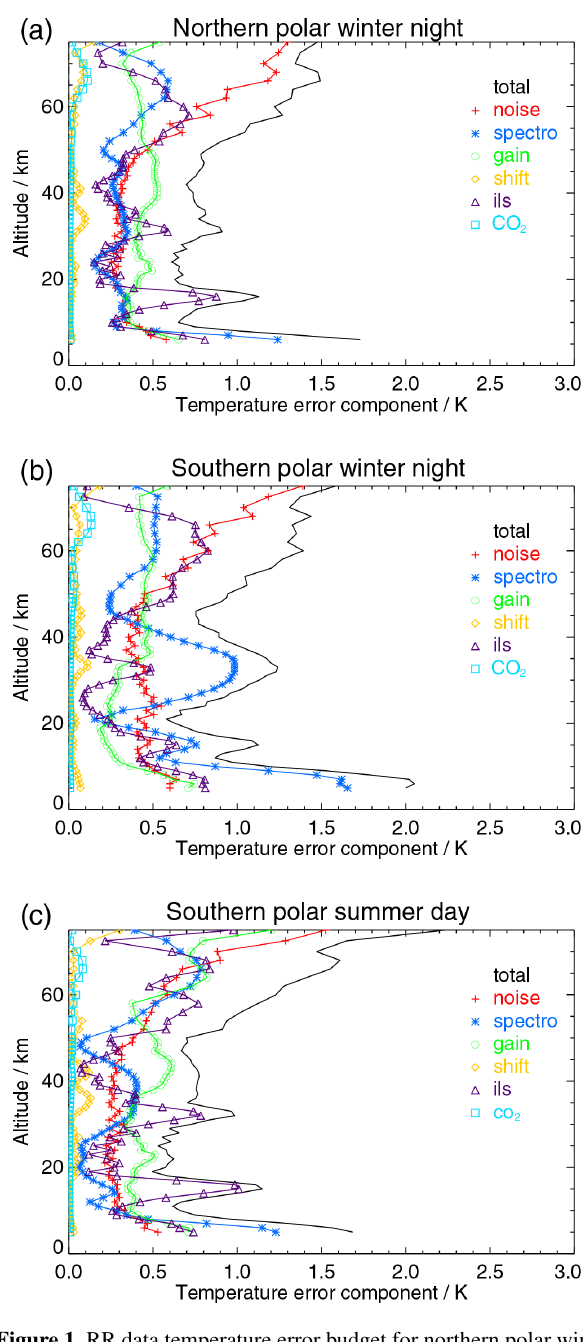
Figure 1. RR data temperature error budget for northern polar win- ter night (a) , southern polar winter night (b) , and polar summer day (c) atmospheres. All error estimates are 1- σ uncertainties. Error contributions are marked “spectro” for spectroscopic error, “gain” for gain calibration error, “shift” for spectral shift error, “ils” for in- strument line shape error, and “co2” for error due to CO 2 volume mixing ratio